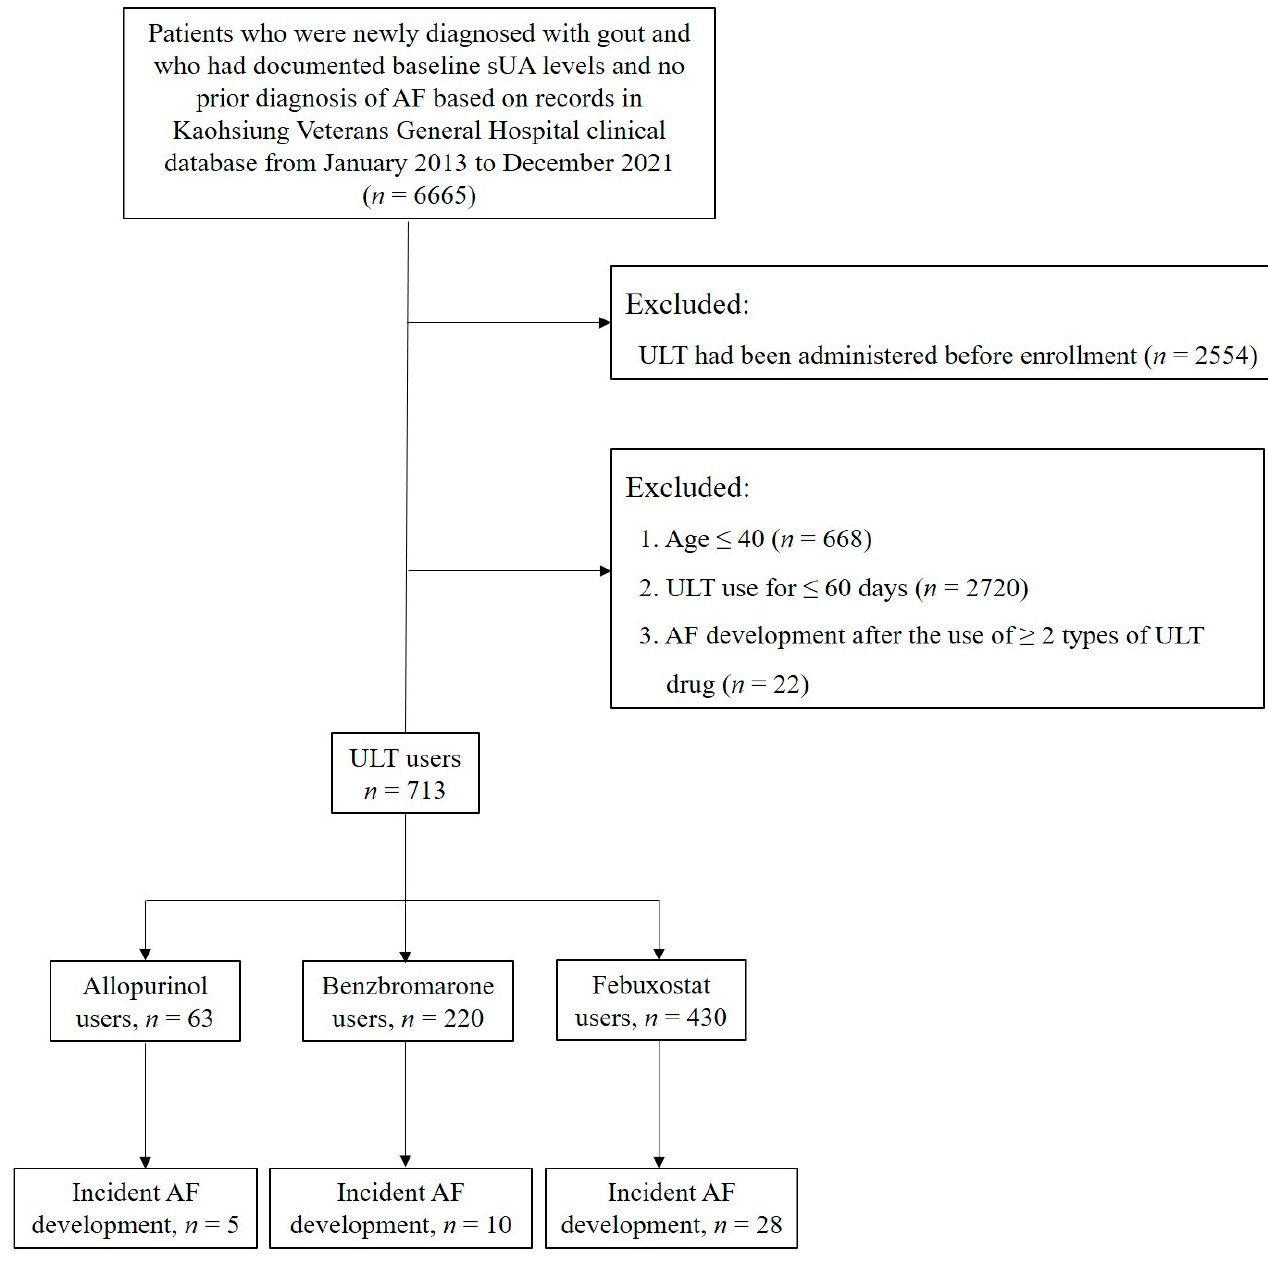
Figure 1. Patient selection flow chart. Abbreviations: AF, atrial fibrillation; sUA, serum uric acid; ULT, urate-lowering therapy.